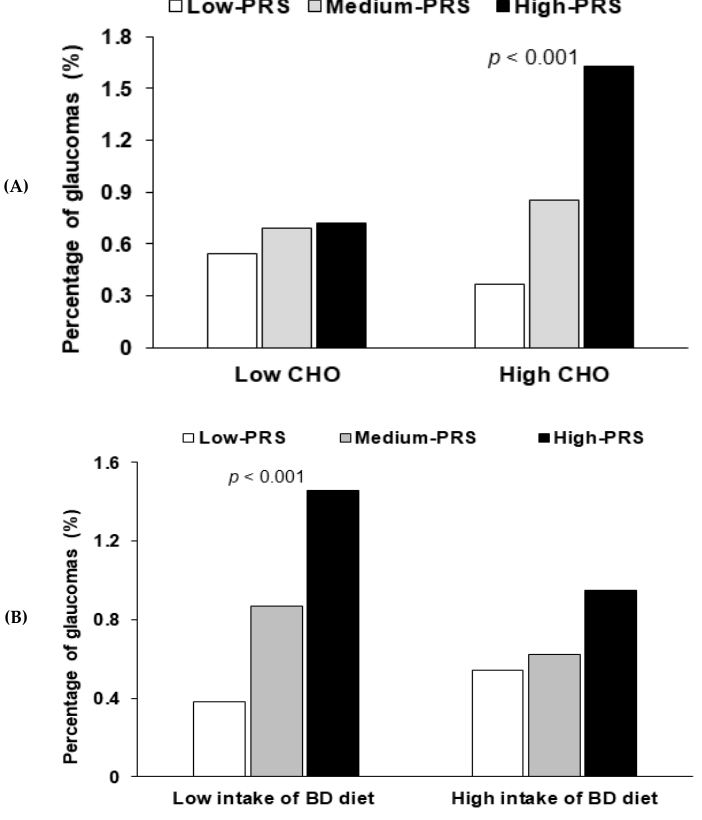
Figure 3. The frequency distribution of glaucoma in the three groups of polygenetic-risk scores (PRS) of the best model including LDB2 rs3763969, CDKN2B rs523096, ABO rs2073823, PDE3A rs12314390, and CDH13 rs12449180 according to the nutrient and food intake. ( A ) According to the carbohydrate intake (cutoff point: 70 energy %). CHO, carbohydrate. ( B ) According to the intake of a balanced diet pattern (cutoff point: 70th percentile). PRS